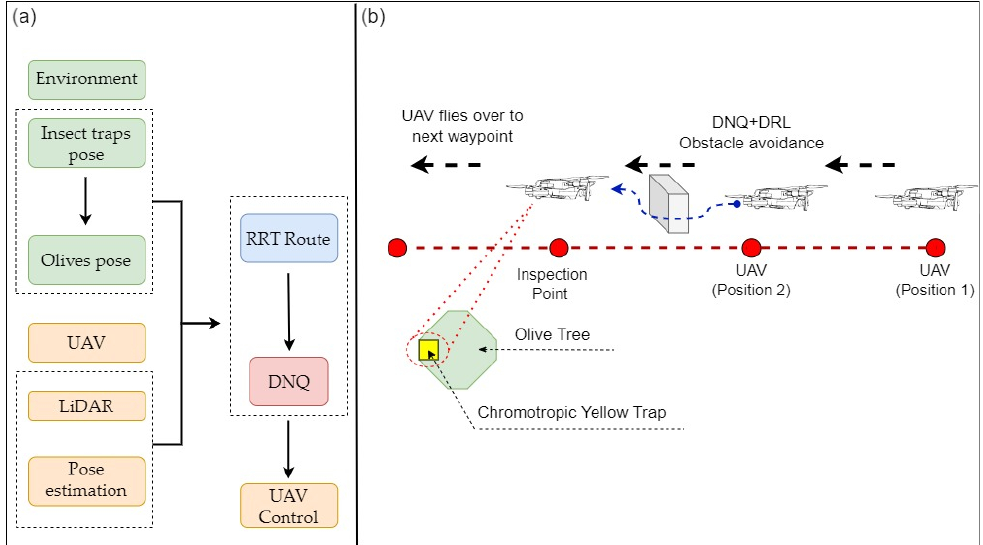
Figure 2. Representation of the UAV trap-inspection process. ( a ) Block diagram of the algorithm agents. ( b ) Representation of the UAV displacement and avoidance